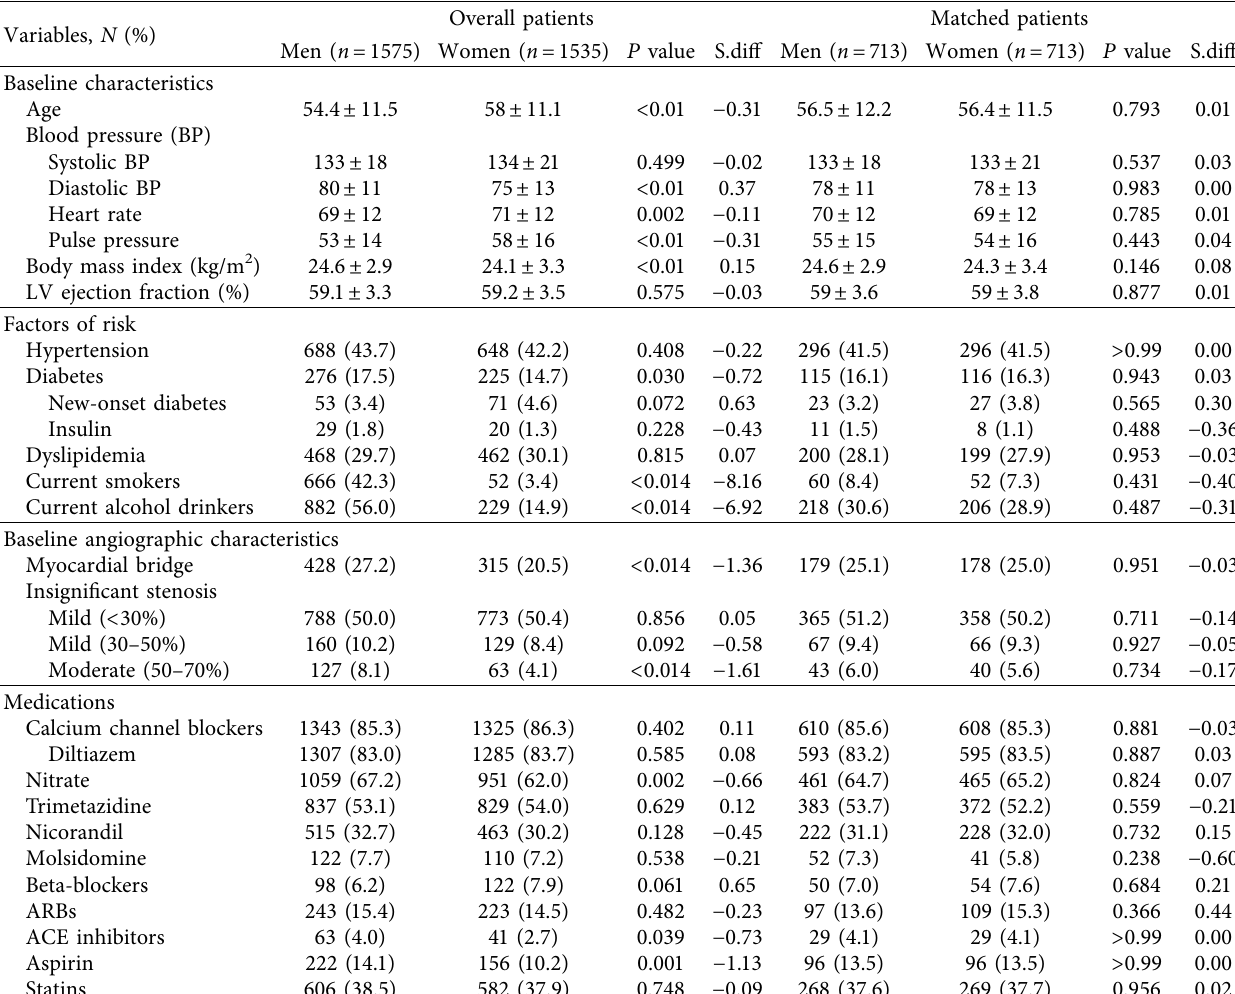
Table 2: Baseline clinical, medical treatment, and angiographic characteristics in patients with coronary artery spasms. Overall Variables, N (%)